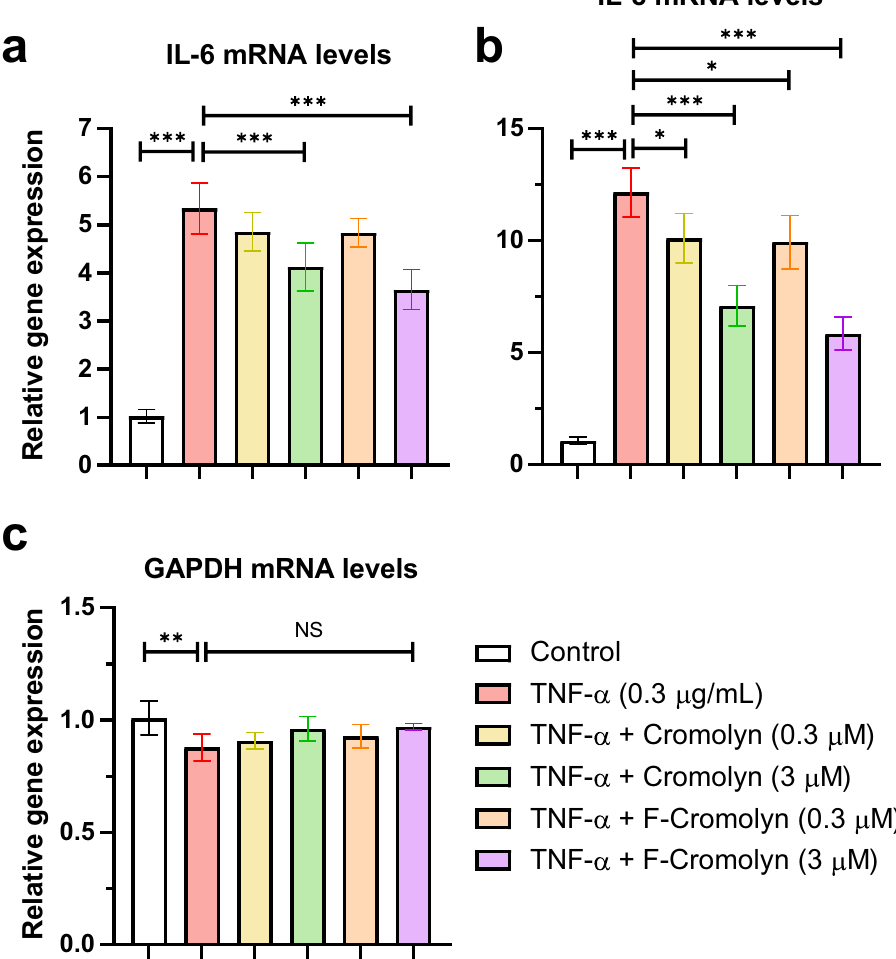
Figure 3. Cromolyn and F-cromolyn decrease the gene expression levels of IL-6 and IL-8 induced by TNF-α in HMC3 human microglia. Quantitative analyses of qRT-PCR assays show the significantly increased gene expression levels of ( a ) IL-6 and ( b ) IL-8 in HMC3 cells treated with TNF-α (0.3 μg/mL, 24 h), which are subsequently decreased by Cromolyn and F-cromolyn (0.3 μM and 3 μM) in a dose-dependent manner. Fold change is normalized to untreated control. ( c ) GAPDH was used as an internal control to normalize mRNA level of the gene of measurement in each sample. NS (no significant difference), * p < 0.05, ** p < 0.01, *** p < 0.001, and n = 5 independent